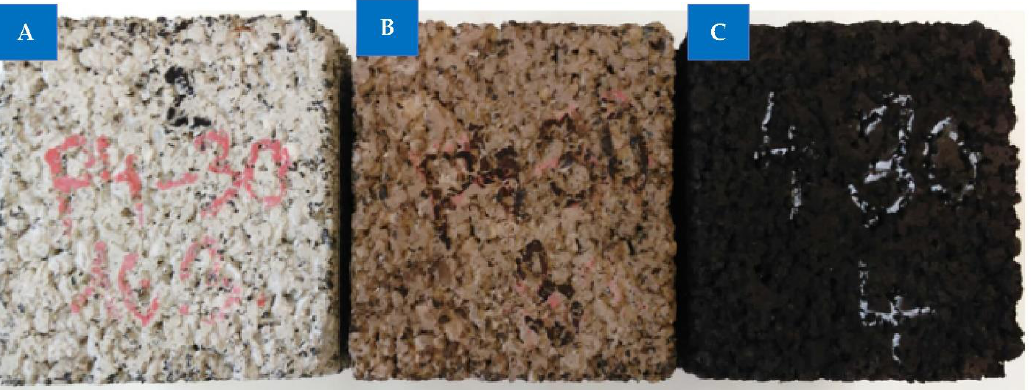
Figure 21. Effect of elevated temperature on rubberized concrete: ( A ) unheated, ( B ) 300 °C, and ( C ) 400 °C [45]: used as per Elsevier permission.